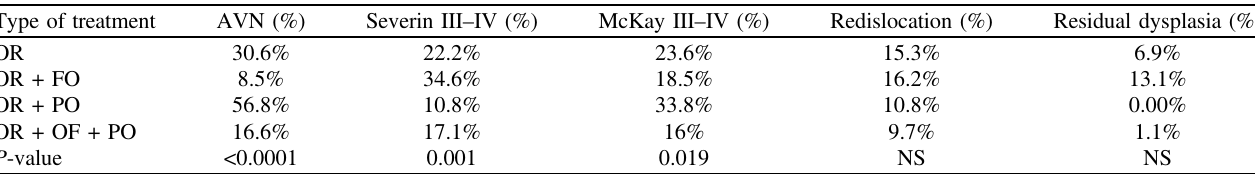
Table 3. Outcomes versus type of